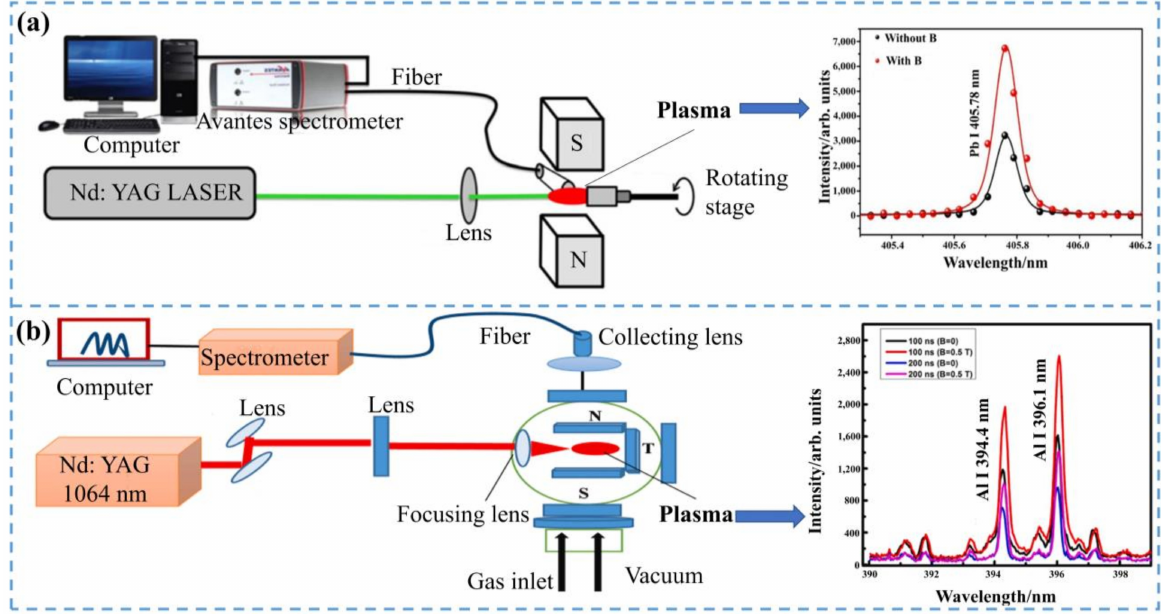
Figure 7. The magnetic field constraint-enhanced LIBS signal device. ( a ) Detection of Pb element; ( b ) detection of Al